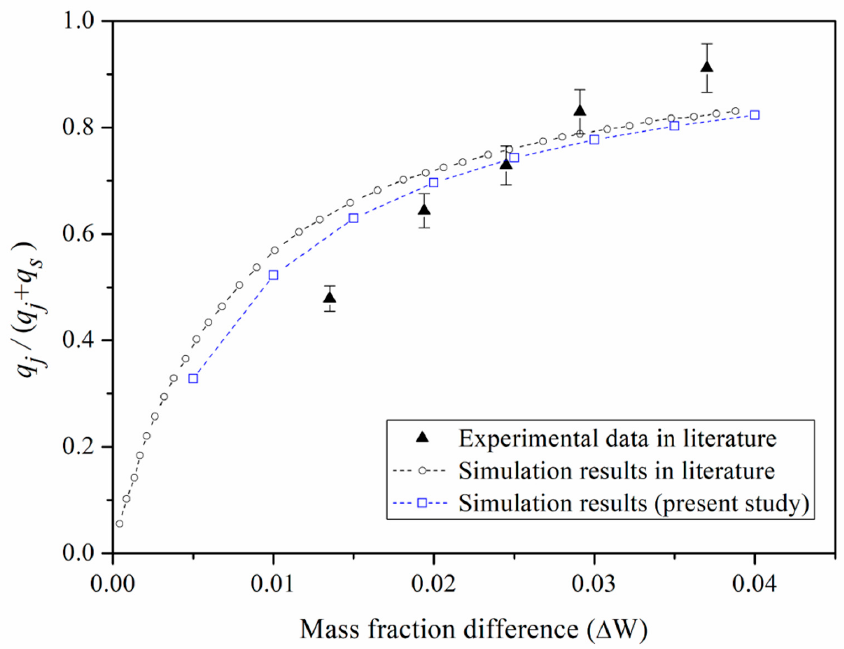
Figure 4. Validation 2: Water vapor condensation determined by the present mathematical model, previous simulation results [35], and experimental data [34].